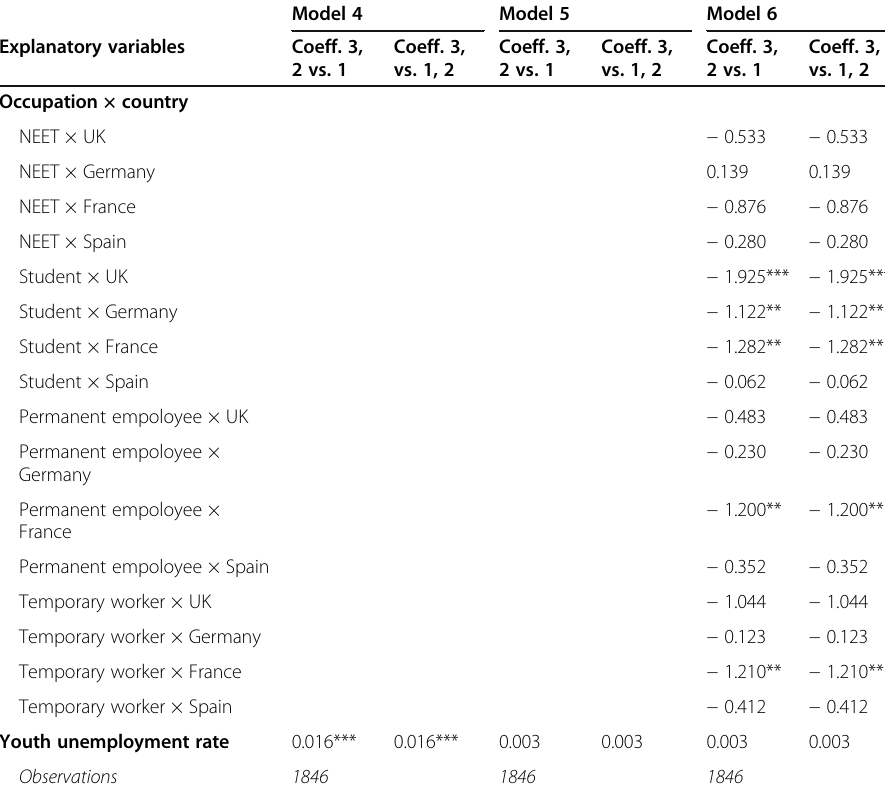
Table 5 Results of generalized ordered logistic regression for the determinants of the decision of postponing or abandoning the plan of going to live on their own